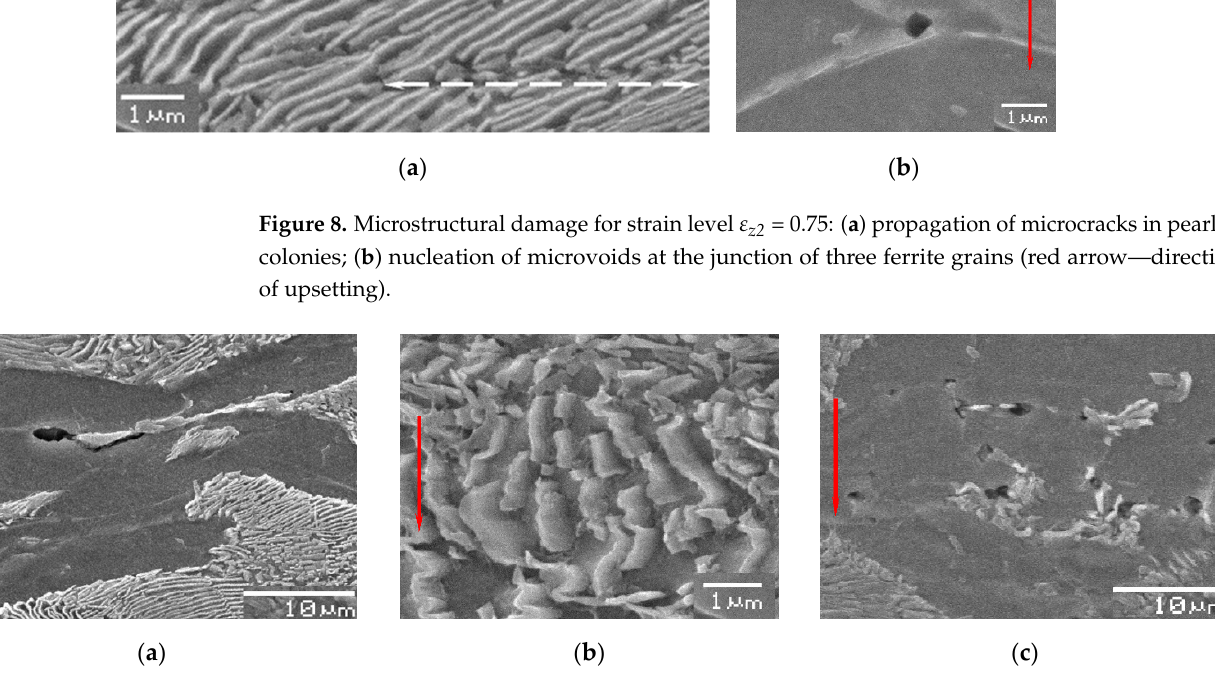
Figure 9. Microstructural damage for strain level ε z3 = 1.1: ( a ) development of a microcrack in the ferrite base; ( b ) fracture of cementite lamellae; ( c ) microdamages caused by decohesion at the fer- rite/ferrite or ferrite/pearlite boundary surfaces (red arrow—direction of upsetting).